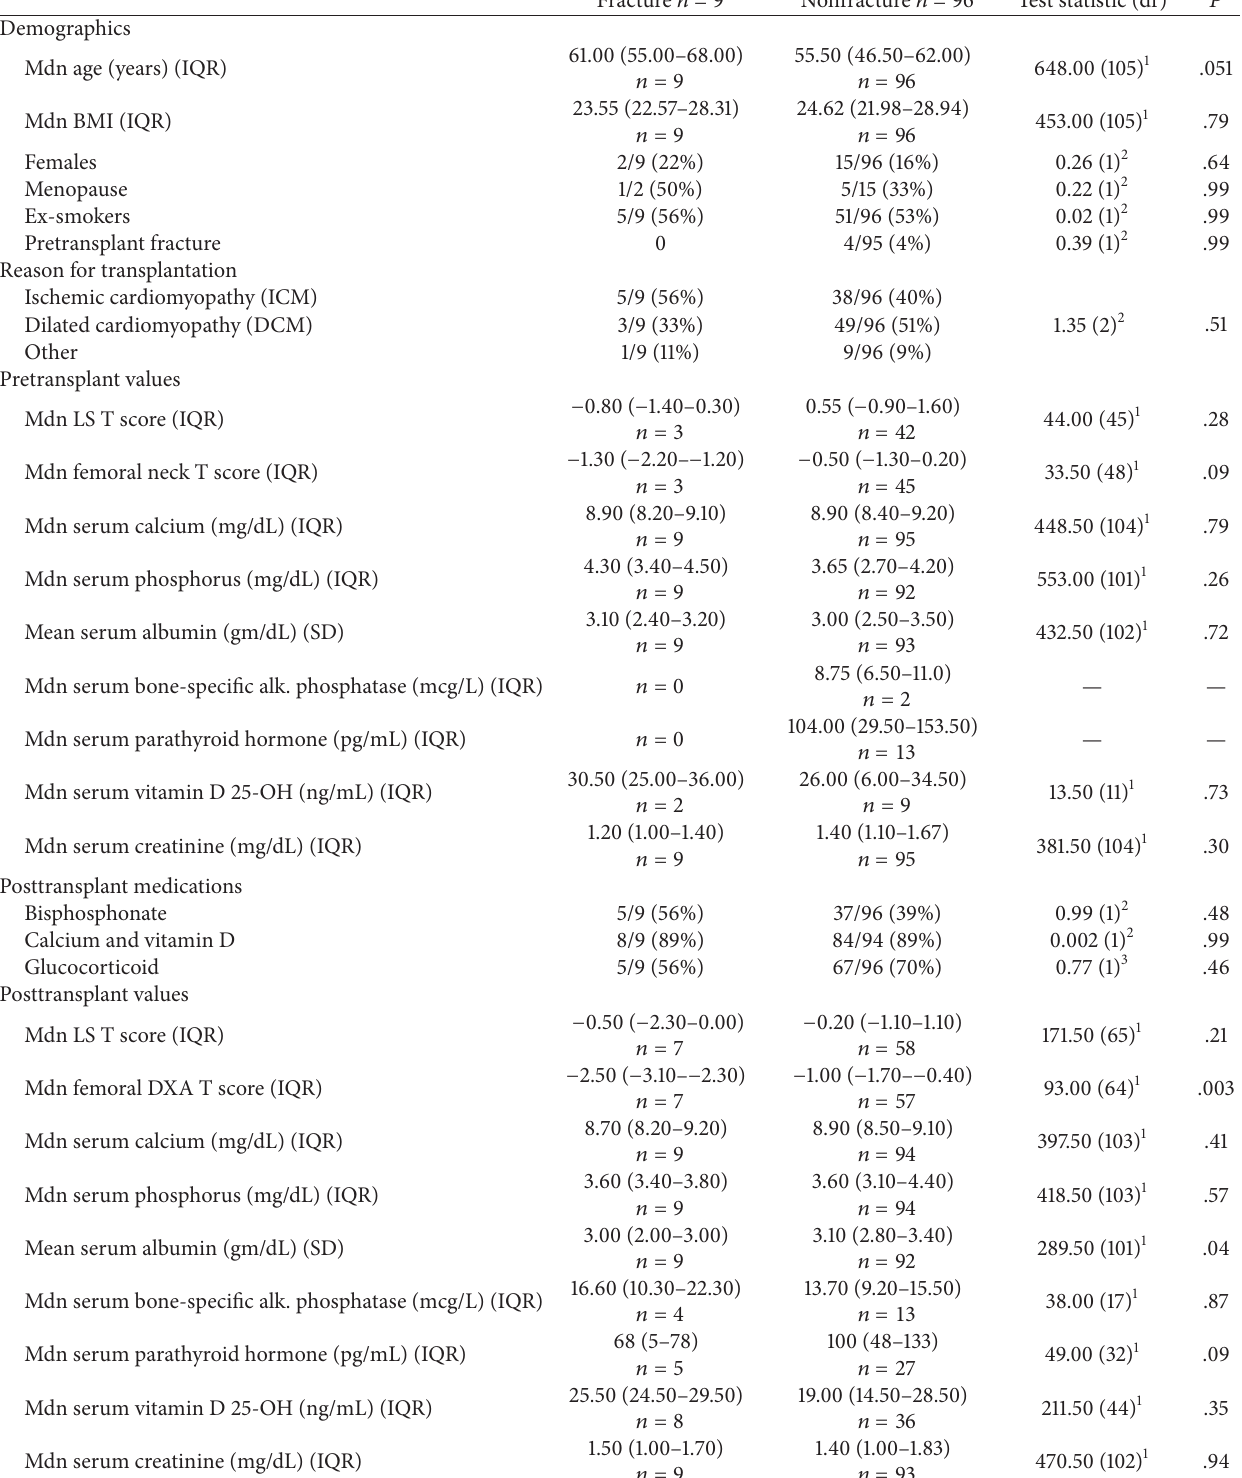
Table 3: Comparison of those with fractures versus no fractures in the heart transplant